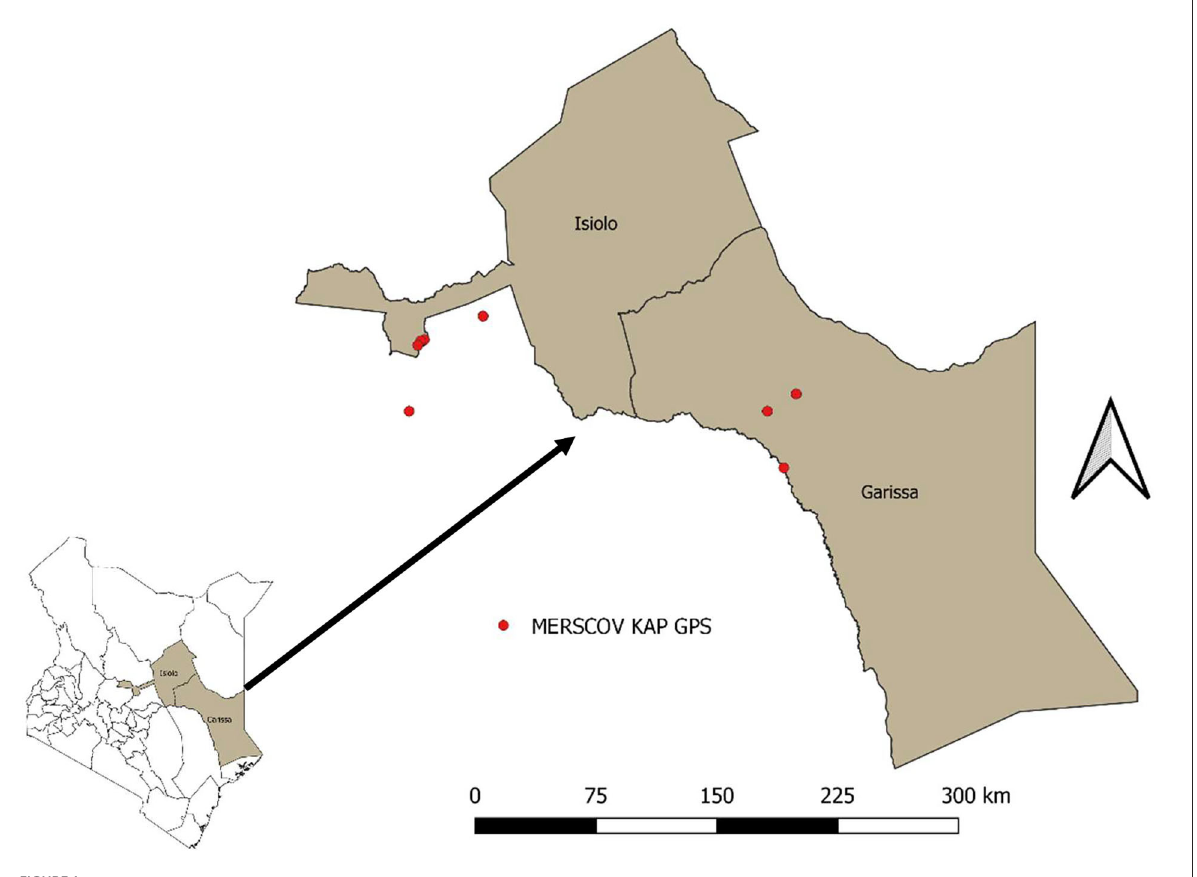
FIGURE1 Map of areas where the survey was